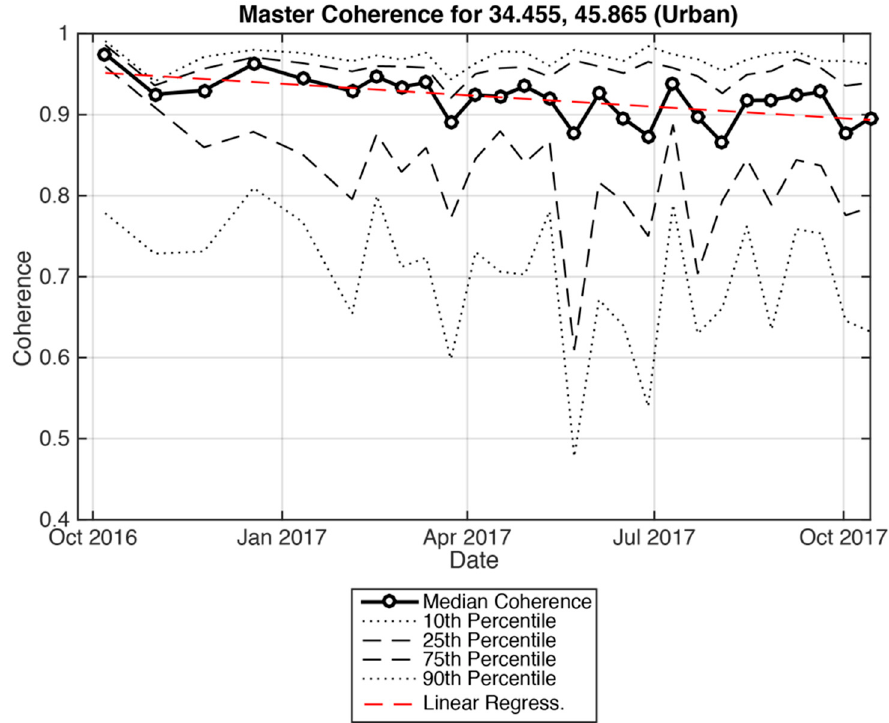
Figure 9. Coherence loss with a decrease of ~0.0014/week (R = − 0.608) from a primary date (7 October 2016) to all subsequent secondary dates for a stable, coherent region (urban building) in Sarpol-e, Iran (see Figure 2A for location), demonstrating the protracted decrease in interferometric coherence with time. Because the low rate of decay of the coherence signal in stable areas, we deem it acceptable to compare the ~4-week recurrence interval Sentinel-1A SAR images to the ~2-week recurrence interval Sentinel-1A/B images.